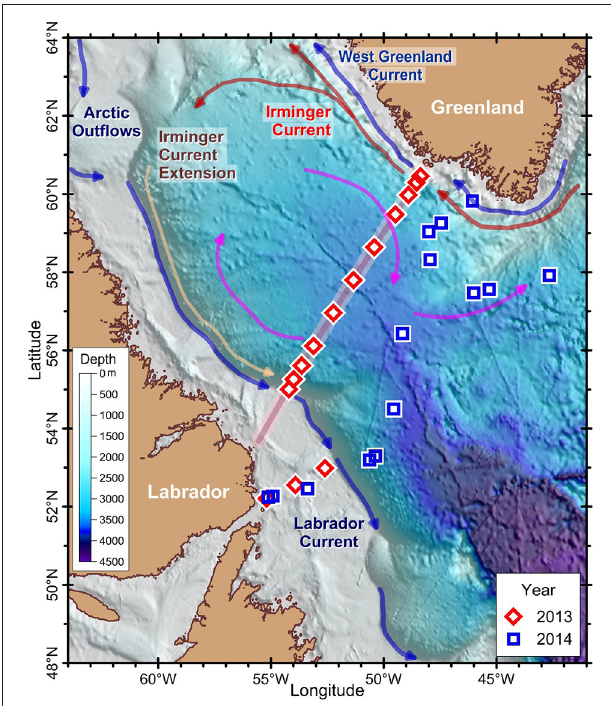
FIGURE 1 | Map showing the stations and a simplified scheme of currents of the Labrador Sea. Stations were sampled along (2013, red diamond) or south of the AR7W transect (background red line) (2014, blue square). Scale refers to bathymetry. Circulation elements of the Labrador Sea: cold currents of Arctic origin (Labrador and West Greenland Currents, blue arrows), warm currents of Atlantic origin [Irminger Current (red arrows) and Extension (brown arrows)] and the anticyclonic circulation gyre (pink